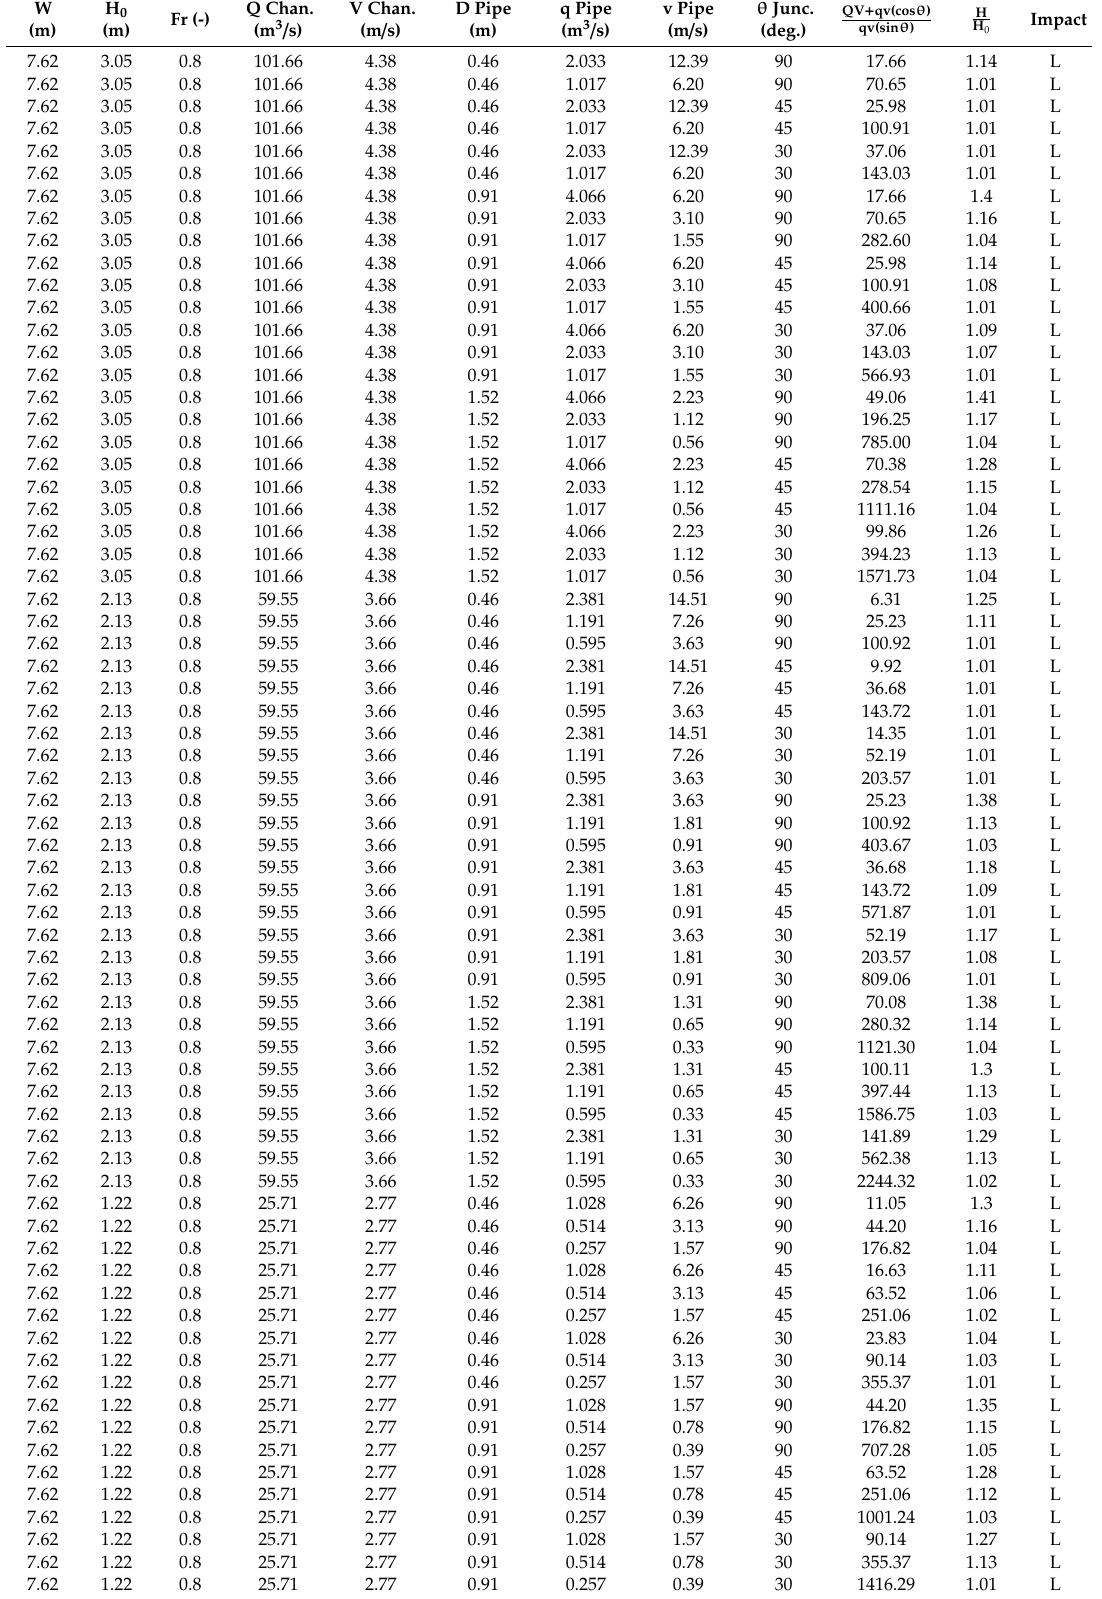
Table A8. FLOW-3D simulation results for W = 7.62 m (25 (cid:48) ) and Fr =